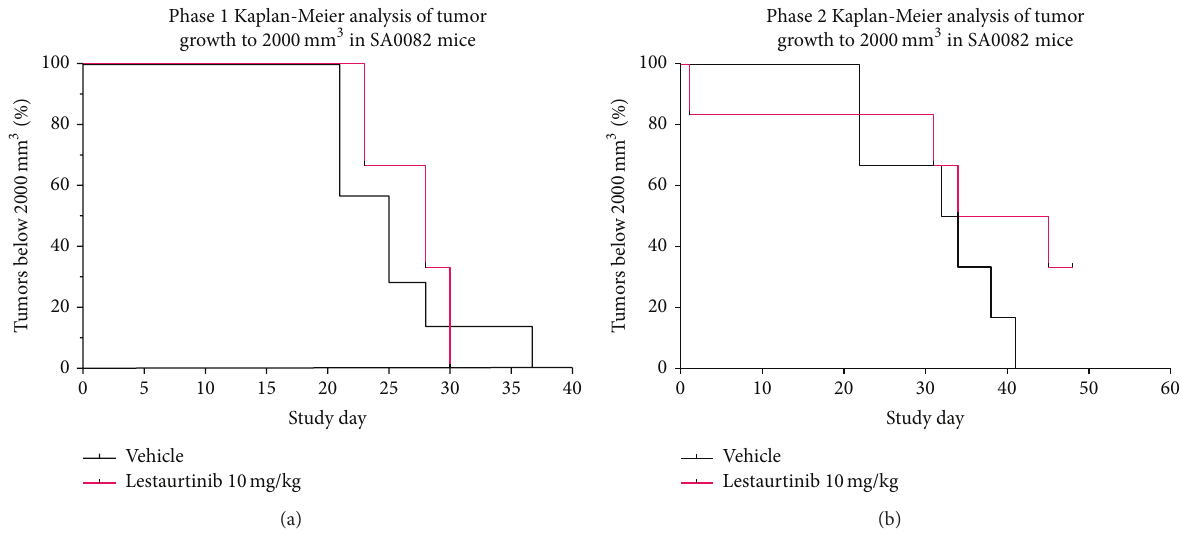
Figure 2: Preclinical testing of lestaurtinib in a parameningeal PDX. (a, b) Kaplan-Meier analysis of PDX mice from two different treatment